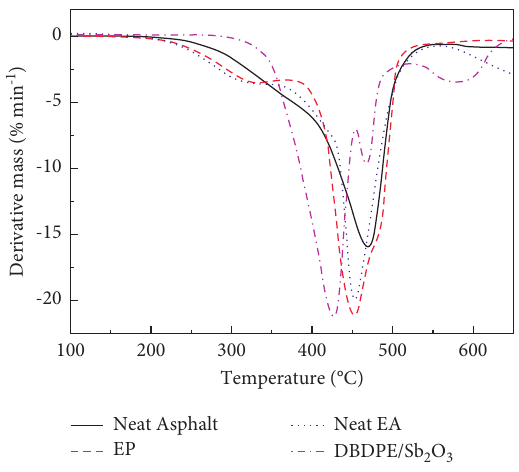
Figure 14: First derivative of the TGA curve [36].